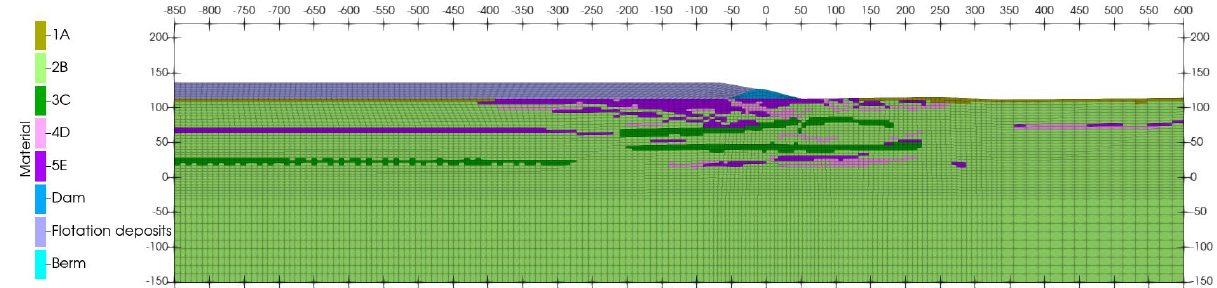
Figure 2: Geometry and mesh of numerical model at computational step 0.